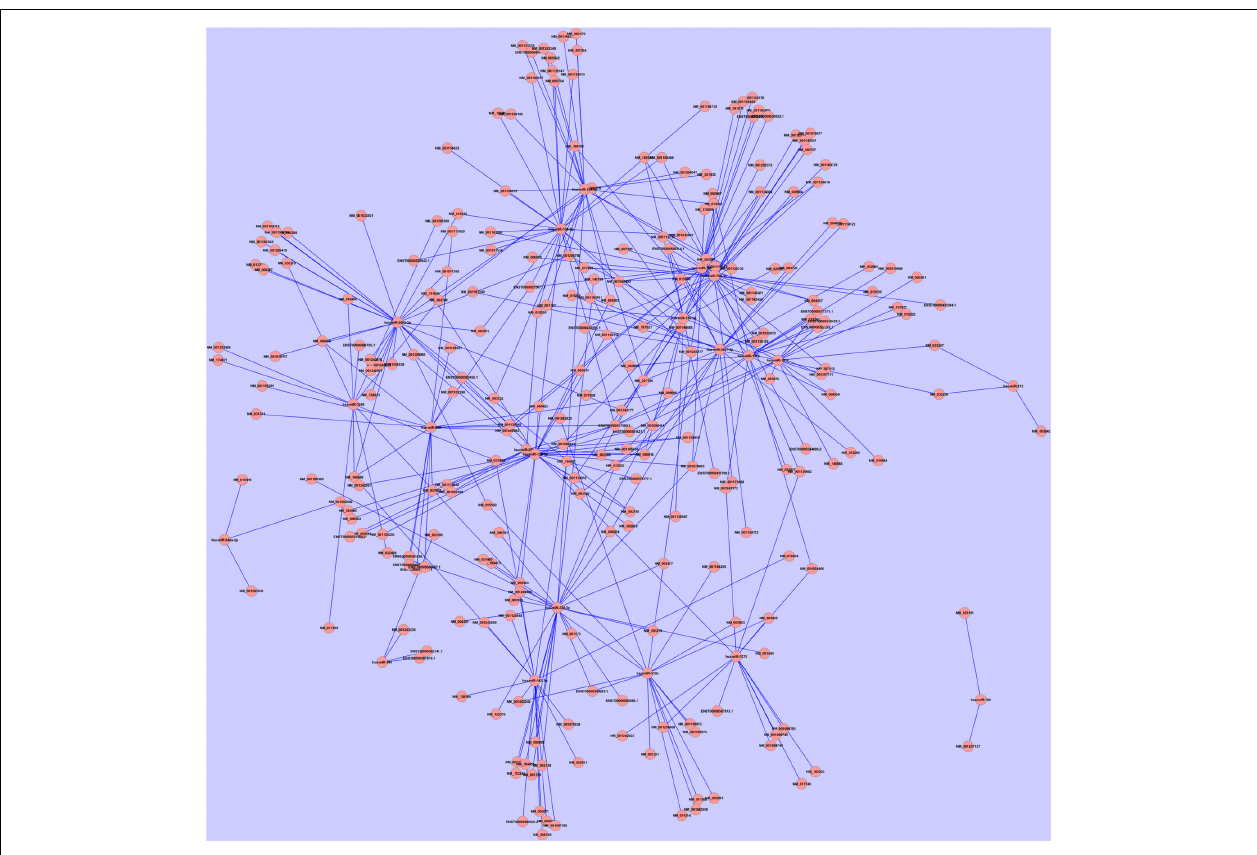
FIGURE 4 | The ceRNA network around the 24 host immune response associatedgenes(listedinTable 2). Thisnetworkcomprisesof246transcripts (217 protein-coding and 29 non-coding), targeted by 21 distinct host miRNAs,